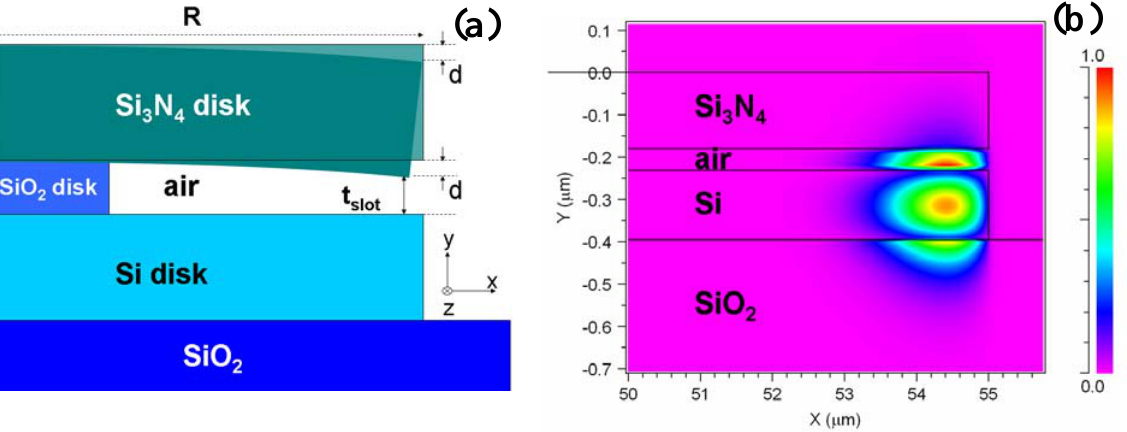
Figure 11. (a) Schematic cross-section of a horizontal slot-waveguide disk resonator of radius R for the detection of nanomechanical forces. Bending (d) of the Si changes the slot distance t , which in its turn changes the effective index of the optical slot mode in the disk. (b) Calculated TM optical mode in the horizontal slot-waveguide disk resonator for d = 0 (no